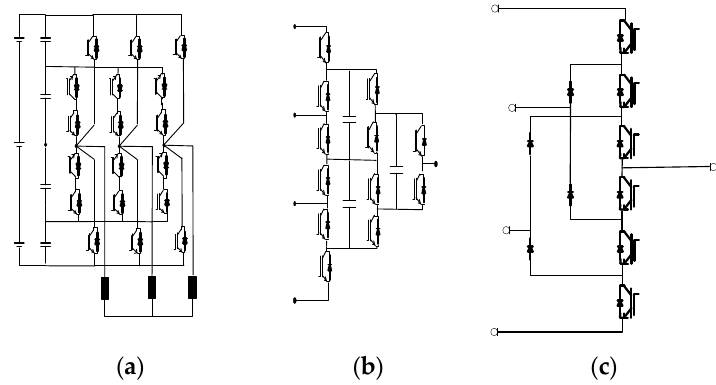
Figure 10. Topologies proposed in the technical literature. ( a ) Nested multilevel configuration with four levels [42]. ( b ) Four-level inverter proposed by [39]. ( c ) Diode clamping multilevel inverter. Table 7. Comparison between the proposed 4LT 2 C and other topologies.